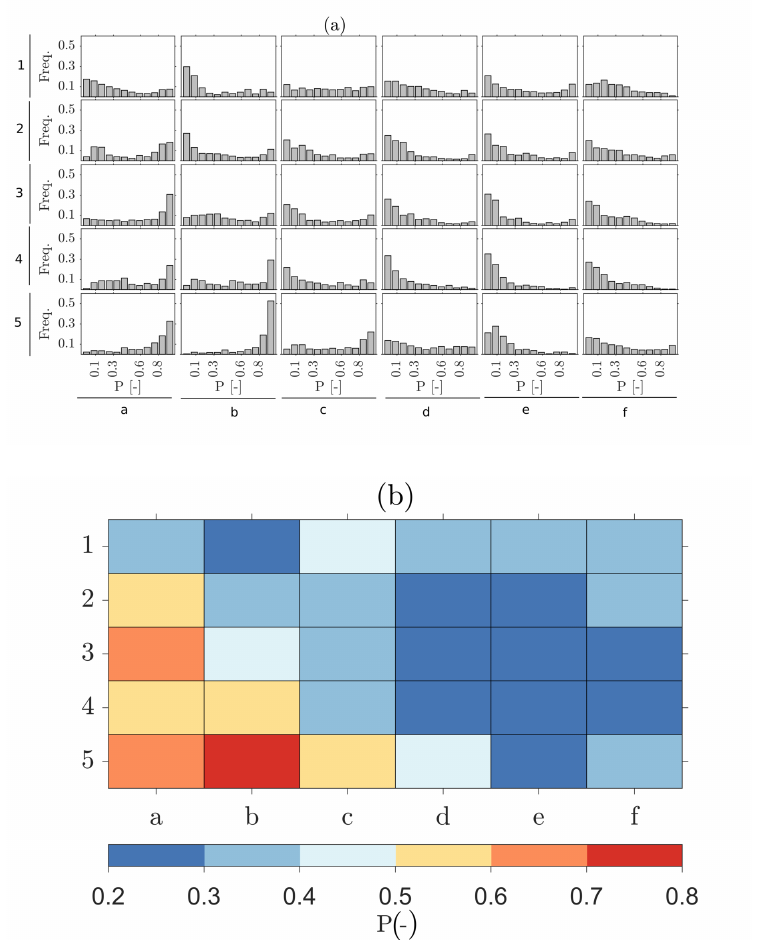
Figure 6. Normalized wind power production by weather patterns: ( a ) distribution of normalized wind power, and ( b ) mean value of normalized wind power (mean capacity